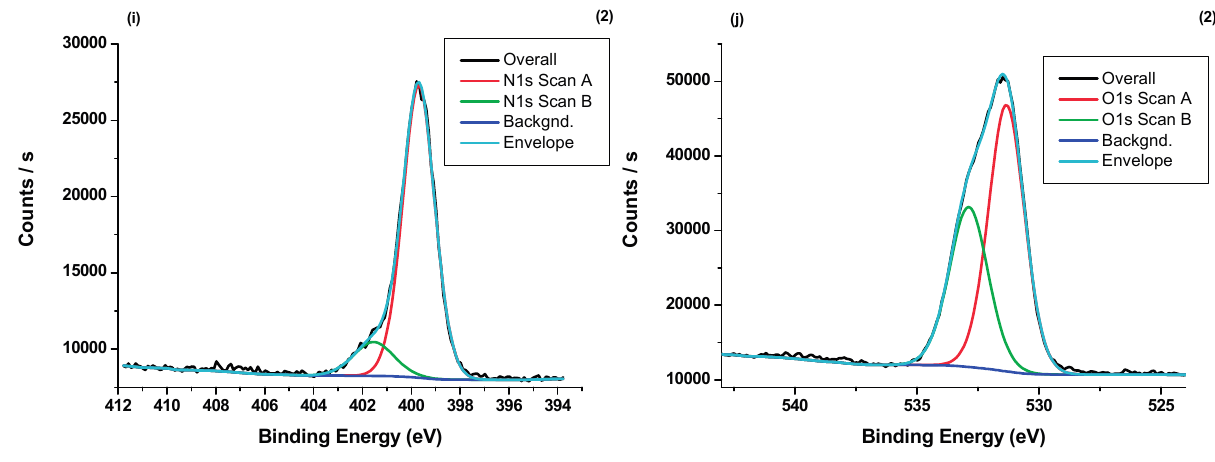
Figure 1. Survey XPS spectrum of 1 ( a ) and 2 ( b ), showing all elements except hydrogens. XPS spectrum of 1 : ( c ) C 1s region, ( d ) Gd 4d region, ( e ) N 1s region and ( f ) O 1s region. 2 : ( g ) C 1s region, ( h ) Gd 4d region, ( i ) N 1s region and ( j ) O 1s region.